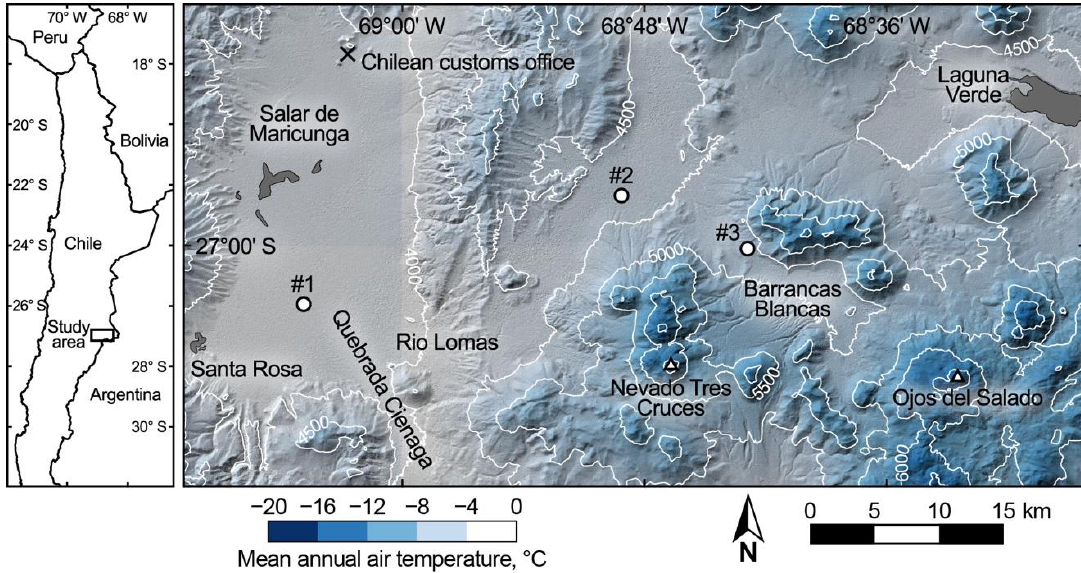
Figure 2. Maps showing the study area and the mean annual air temperature for 2018. The numbered circles indicate the locations of validation sites where we measured subsurface ground temperatures. The Chilean customs office is marked with an ✕ symbol. The air temperatures were calculated from the GHCN CAMPS long-term (1981 – 2010) monthly mean dataset of air temperature (0.5° pixel −1 [35]) and were scaled to the resolution of SRTM DEM (30 m pixel −1 ) using the long-term (1981 – 2010) monthly mean NCEP/NCAR reanalysis dataset of lapse rate (2.5° pixel −1 [37]). The background hillshade image was constructed from 1 arcsec SRTM DEM (SRTMGL1).